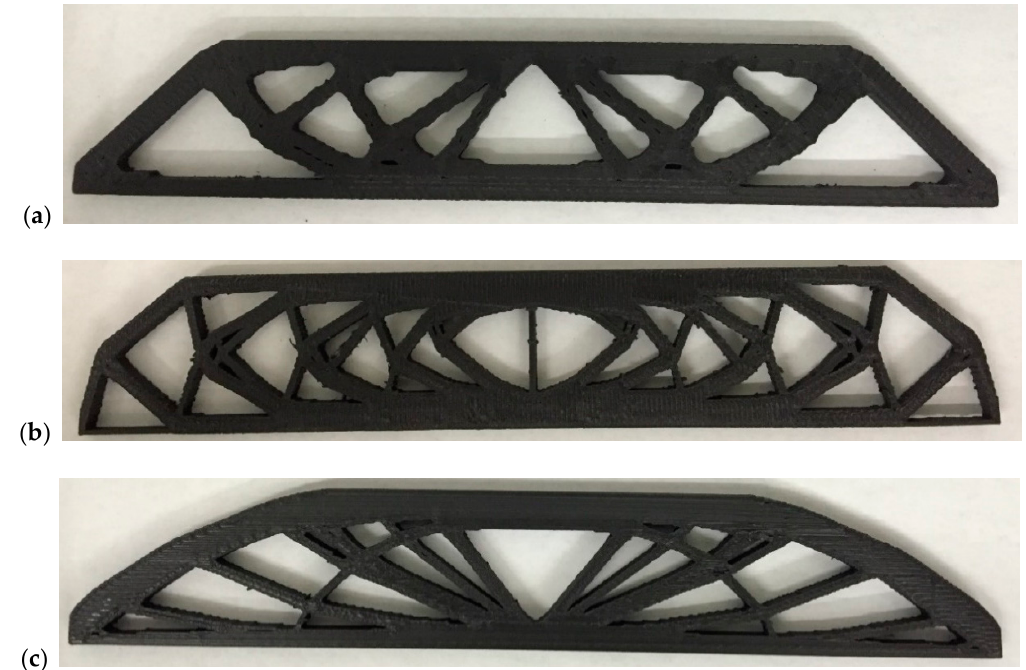
Figure 7. Printed optimized MBB beams: ( a ) CFAO optimized beam from Figure 4, ( b ) optimized for fixed horizontal print direction ( θ e = 0) (Adapted from Reference [45]), and ( c ) optimized for fixed vertical print direction ( 𝜃 (cid:3032) = 90°) (Adapted from Reference [45]).